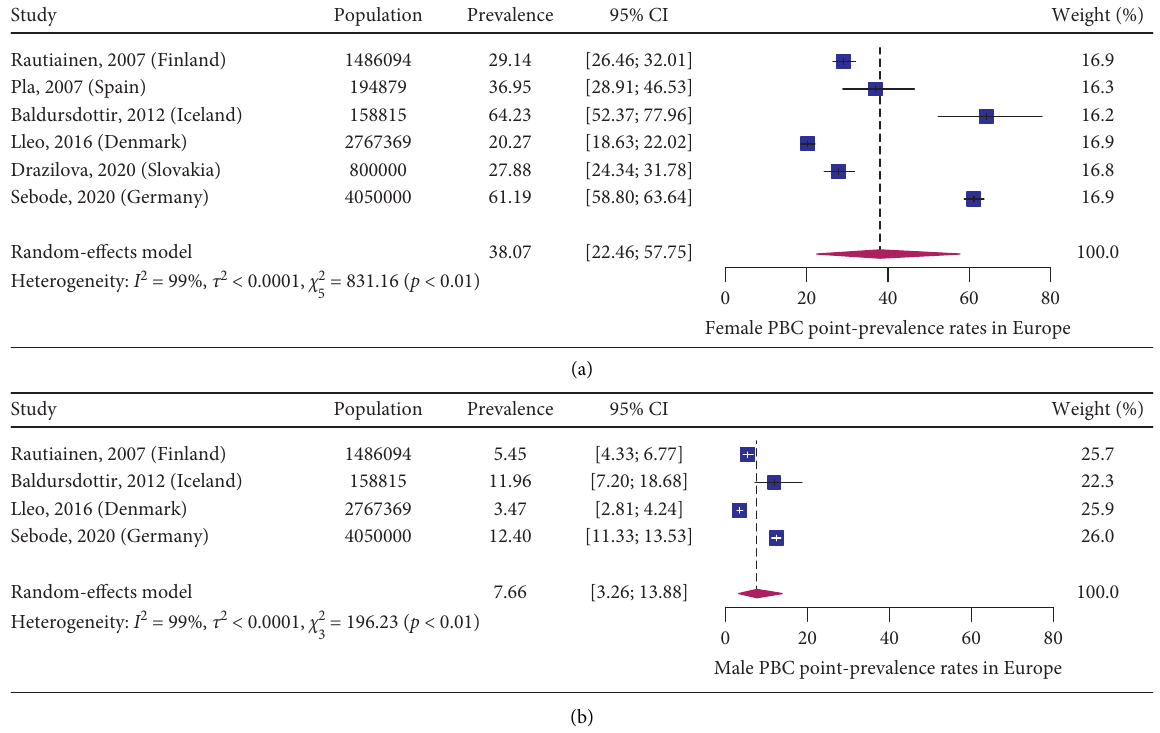
Figure 6: (a) Female PBC point-prevalence rates in Europe. (b) Male PBC point-prevalence rates in